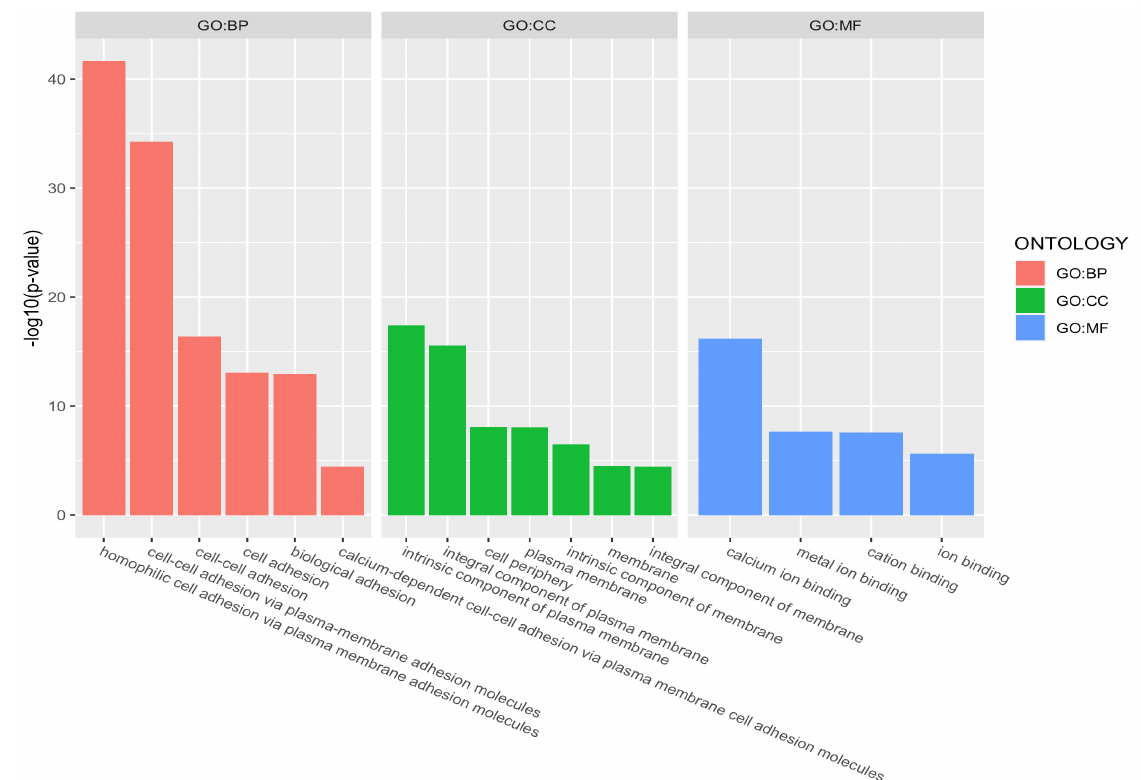
Figure 7. Gene Ontology terms showing over-representation with corrected p -values < 0.05, for the list of genes derived from the ACPA-associated DMRs. Abbreviations: BP: Biological Process; CC: Cellular Component; MF: Molecular Function. Table 6. Gene Ontology terms that collectively show over-representation in all gene sets, at corrected p -value < 0.05.